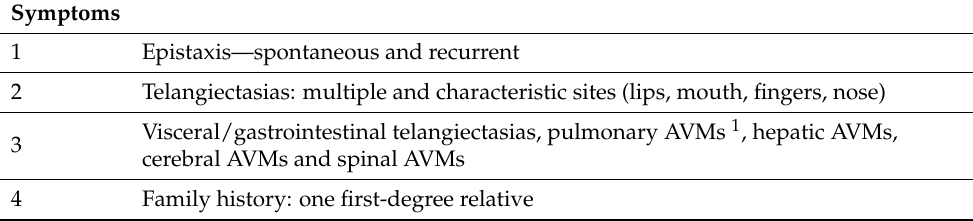
Table 1. Curaçao diagnostic criteria for HHT